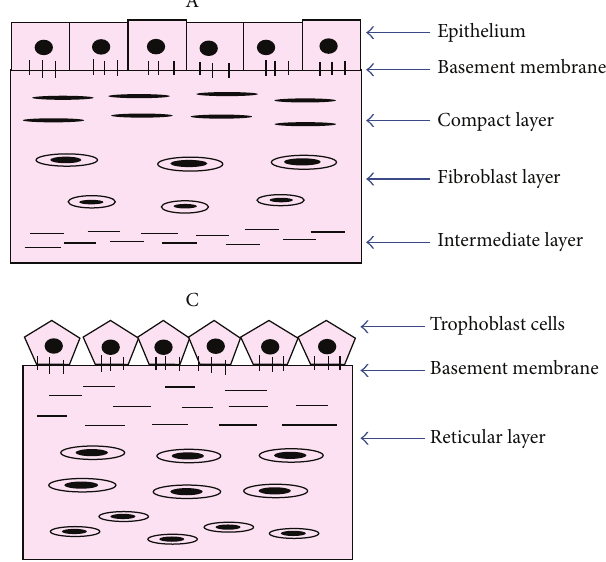
Figure 2: Line diagrammatic representation of histological archi- tecture of amnion (A) and chorion (C)